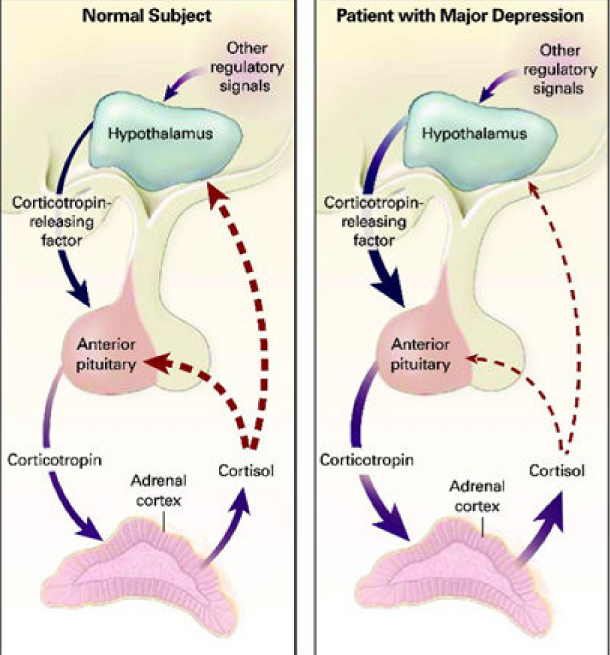
Figure 1. Daskalakis, N.P.; McGill, M.A.; Lehrner, A.; Yehuda, R. (2015). Endocrine Aspects of PTSD: Hypothalamic-Pituitary-Adrenal (HPA) Axis and Beyond. Comprehensive Guide to Post- Traumatic Stress Disorder, 1–14. doi:10.1007/978-3-319-08613-2_130-1 [133] HPA axis dysfunction in patients with major depression. Disrupted HPA axis negative feedback, leads to high cortisol levels in depressed